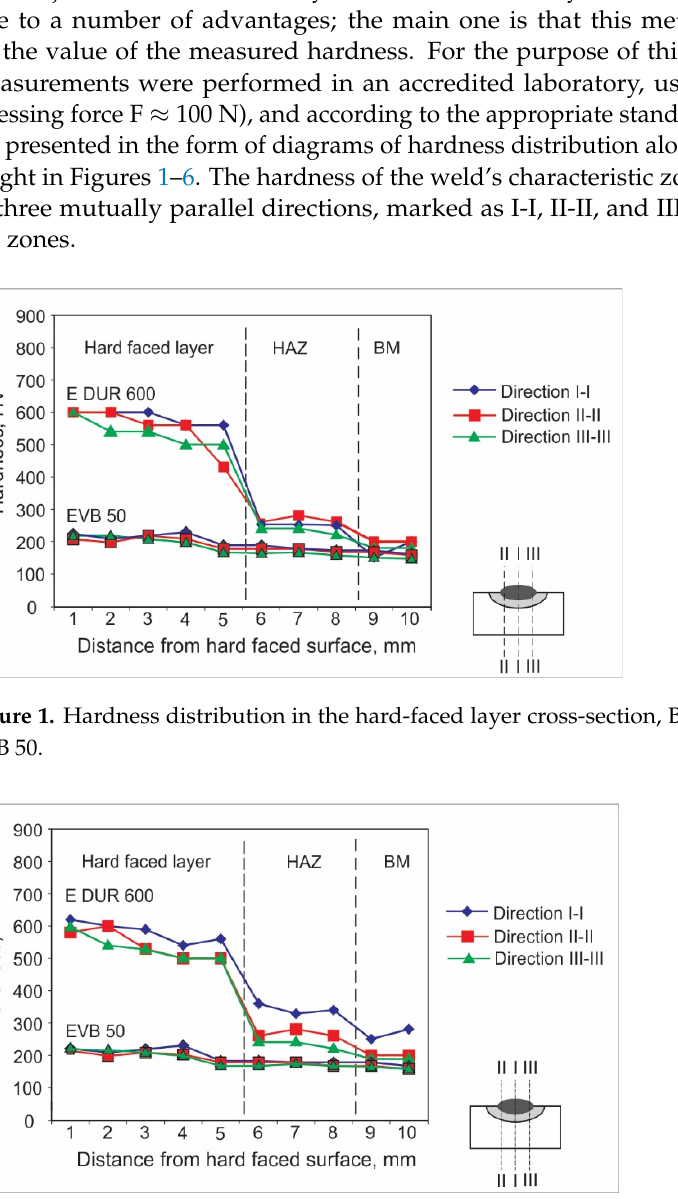
Figure 3. Hardness distribution in the hard-faced layer cross-section, BM-C45, FM-E DUR 600. Figure 4 shows the hardness measurement results obtained for hard-facing by the MMAW procedure with preheating at 280 °C, with electrode E DUR 600 of diameter d e = 3.25 (mm) on the sample, the base metal of which was steel 42CrMo4. From the hard-facing of the low-alloyed tempered steel 42CrMo4 it was established that it behaves similarly to the C45 steel, with regard to both the hard-faced layer’s hard- ness and the layer’s thickness, as well as for the HAZ and BM hardness. It should be pointed out that hardness in the HAZ in both cases decreased gradually from 450 HV to 350 HV within the 2 mm thick layer, as shown in Figures 3 and 4, while for the structural steels that is usually not the case, since their hardness drops abruptly (Figures 1 and 2) and remains at the level reached.